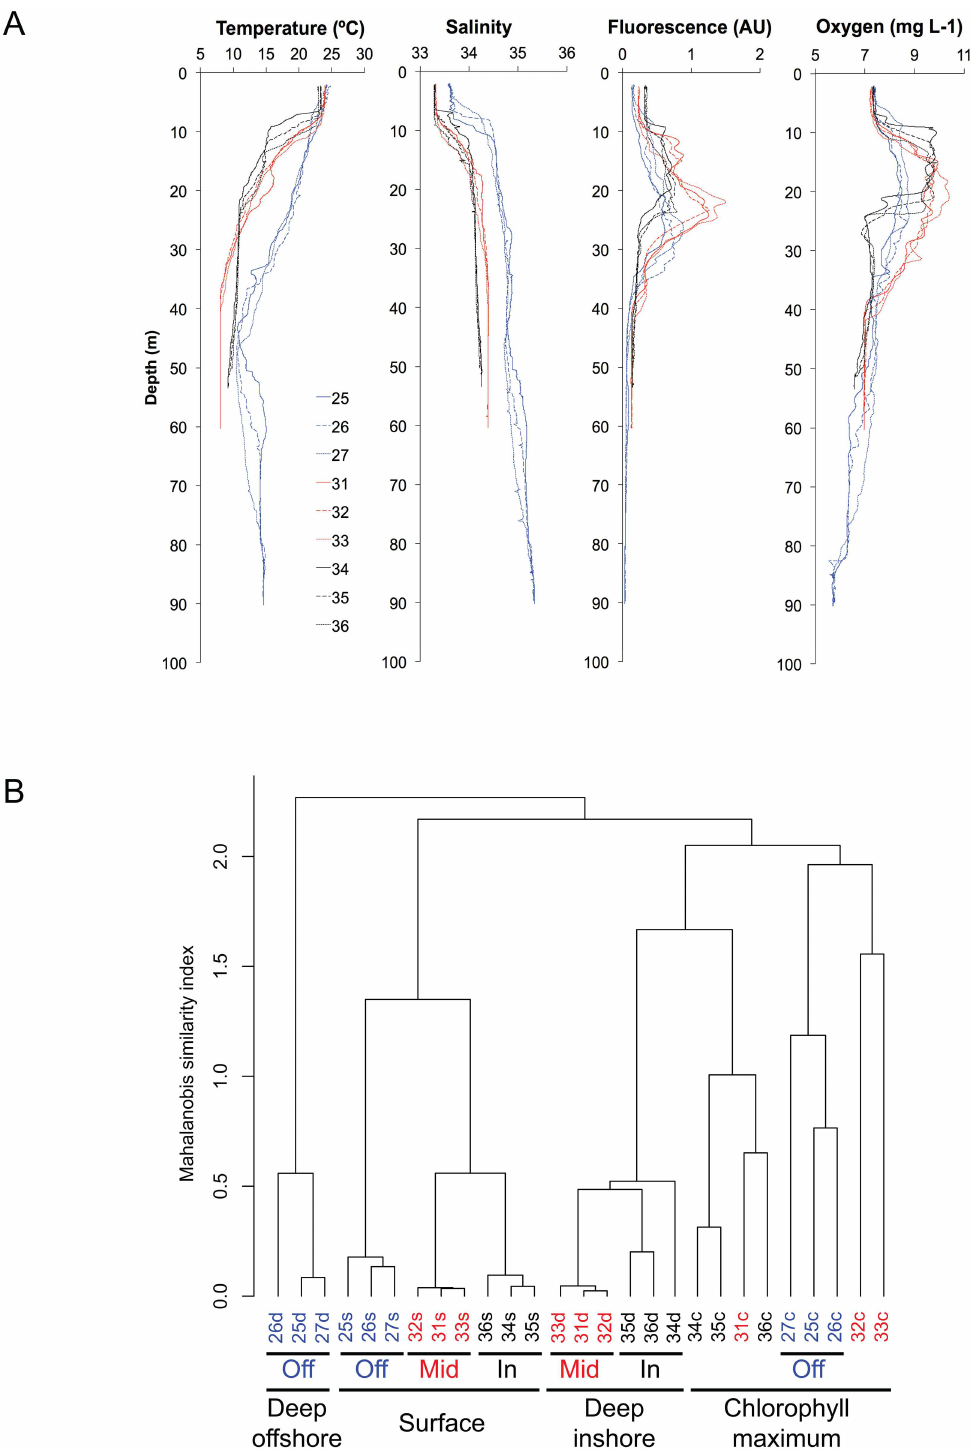
Fig 2. Analyses of environmental parameters. A. Environmental parameters show the separation with the three samplinglocations(blue offshore, red midshoreand black inshore). B. Sample clusteringby environmental parameters using Mahalanobisdistancemetric in R [46] shows similarity by layer (Surface, Chlorophyll maximum and deep) and then by positionon the shore (inshore,midshelf and offshore).